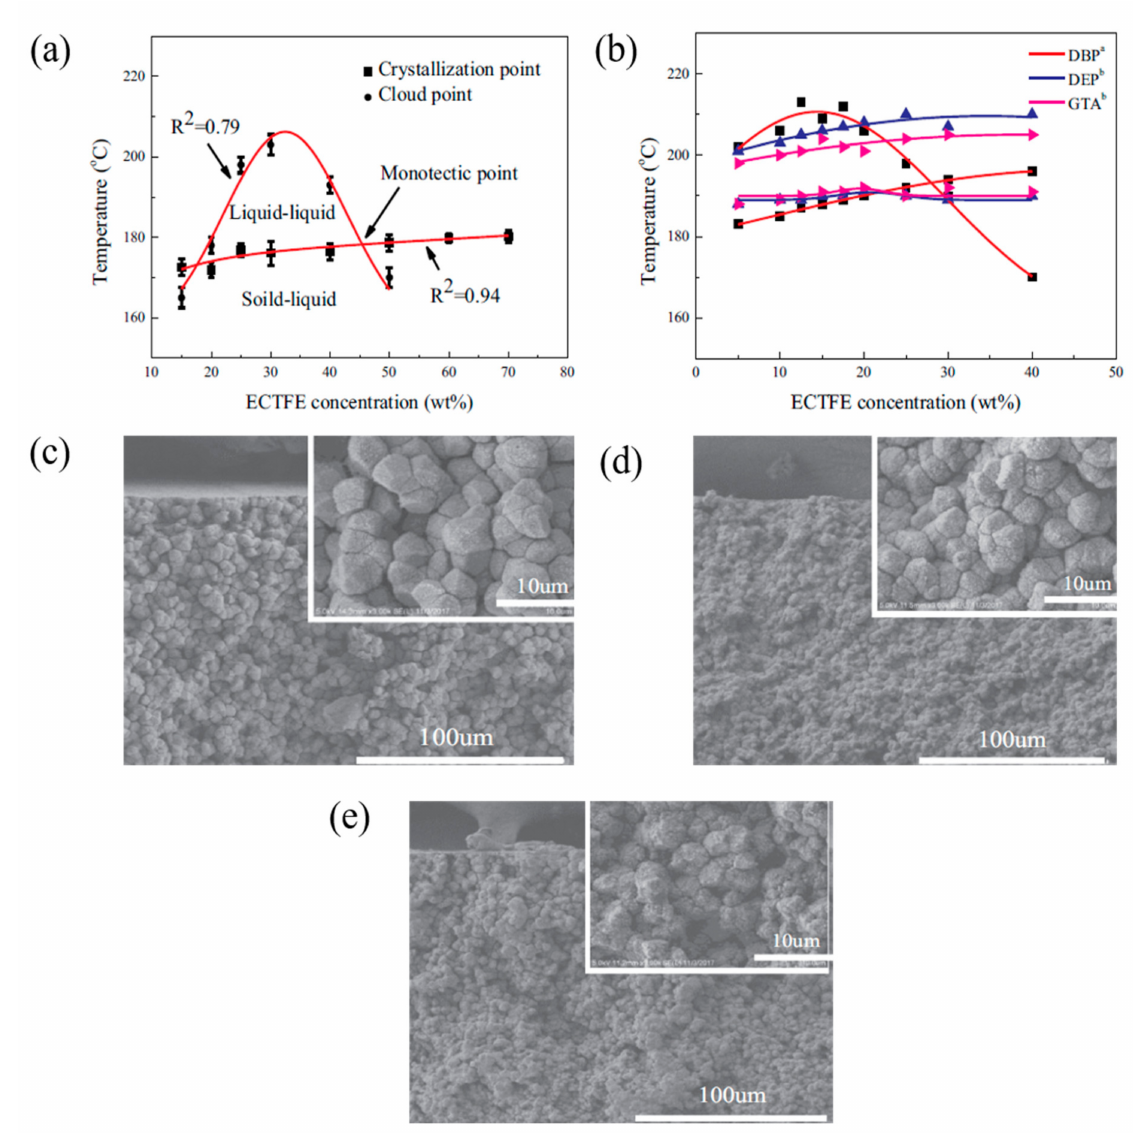
Figure 5. ( a ) Phase diagram of poly(ethylene chlorotrifluoroethylene) (ECTFE)/ATBC; ( b ) phase diagram of ECTFE/glycerol triacetate (GTA), ECTFE/DBP and ECTFE/ diethyl phthalate (DEP); ( c , d ) cross-sectional morphologies of ECTFE membrane with a polymer concentration of 20 and 40 wt.% at a quenching temperature of 20 ◦ C; ( e ) cross-sectional morphologies of ECTFE membrane with a polymer concentration of 30 wt.% at a quenching temperature of 80 ◦ C